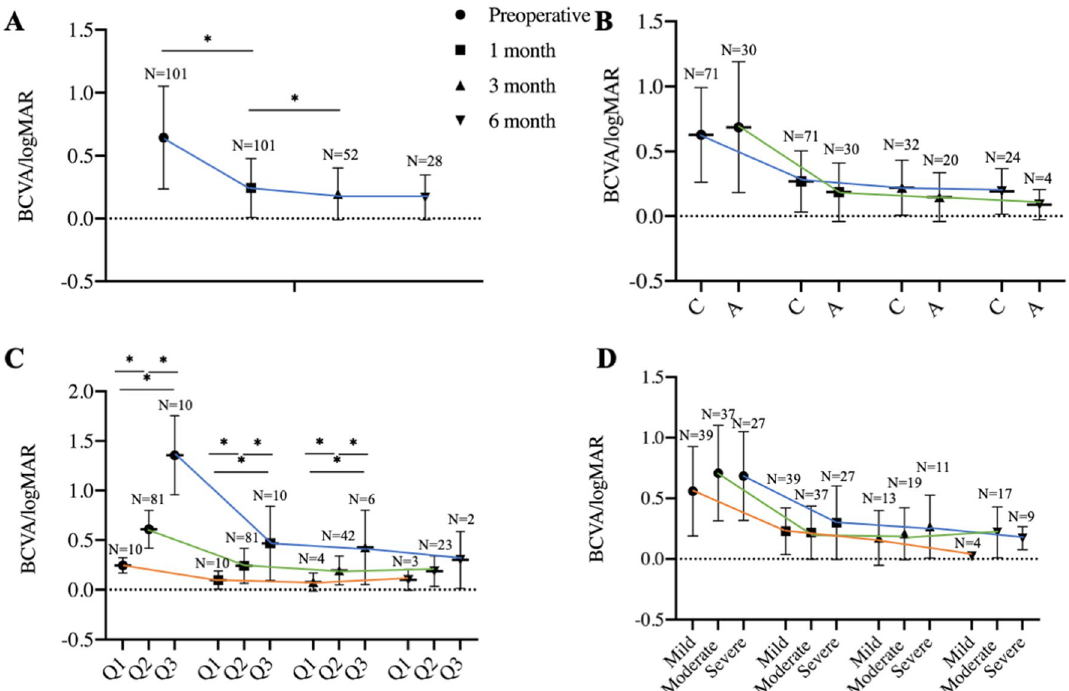
Figure 3. BCVA in eyes that underwent MCTR implantation. ( A ) Changes of BCVA in all patients with MCTR implantation. ( B ) Changes of BCVA in the “children” group and “adult” group. C: Children; A: Adult. ( C ) Changes of BCVA in Q1, Q2, and Q3. Q1: logMAR < 0.3 (Snellen equivalent 20/40); Q2: 0.3 < logMAR < 1 (Snellen equivalent between 20/200 and 20/40); Q3: logMAR > 1 (Snellen equivalent 20/200 or worse). ( D ) Changes of BCVA in variable degrees of lens subluxation. *: P <